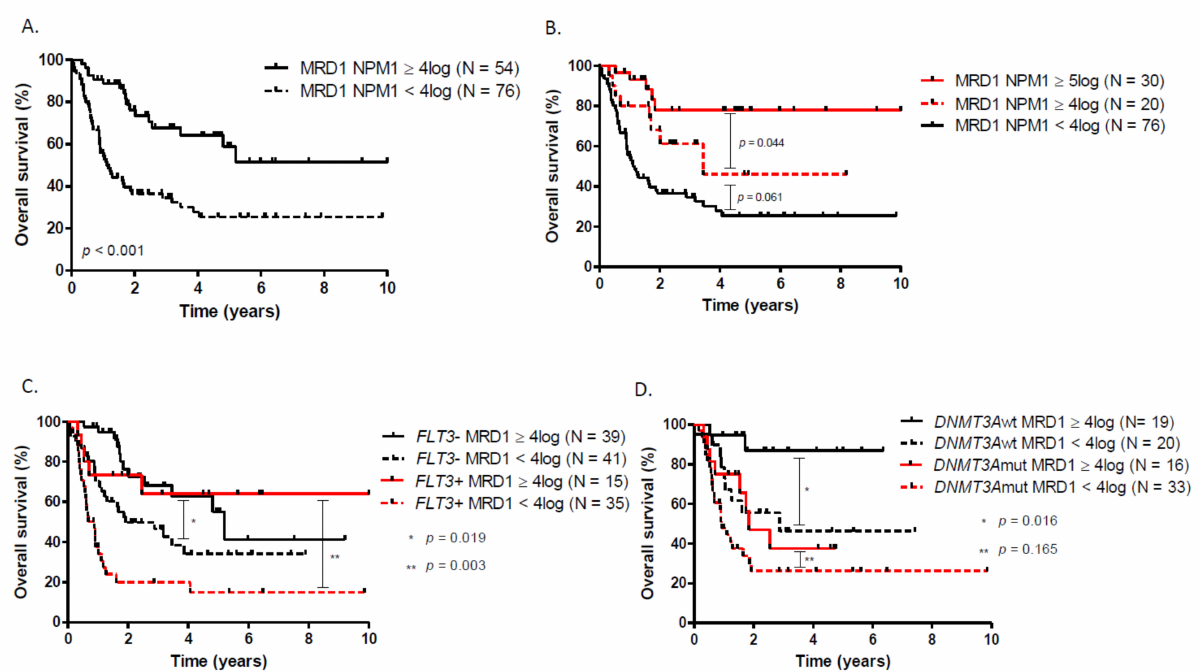
Figure 2. Overall survival according to ( A ) NPM1 MRD1, ( B ) NPM1 MRD1 with a 5log reduction cut-off, ( C ) NPM1 MRD1 in patients with or without FLT3-ITD , ( D ) NPM1 MRD1 in patients with or without DNMT3A .